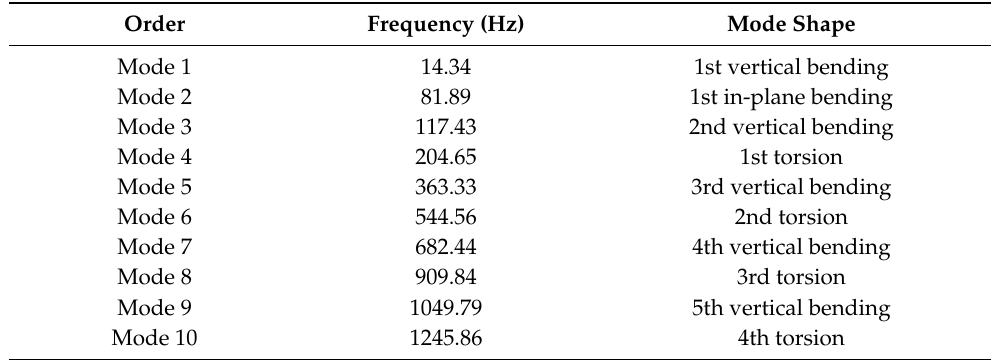
Table 1. The first ten natural modes ( θ = 0